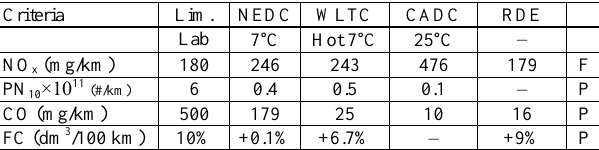
Table 9. Summary of retrofit results (as measured at JRC). F = Fail, P = Pass based on the Retrofit limits because the prototype vehicle was deliv- ered for the Retrofit prize (Table 1). For the lab tests the average of the three cycles was considered as pass/fail criterion. Lim. = Limits